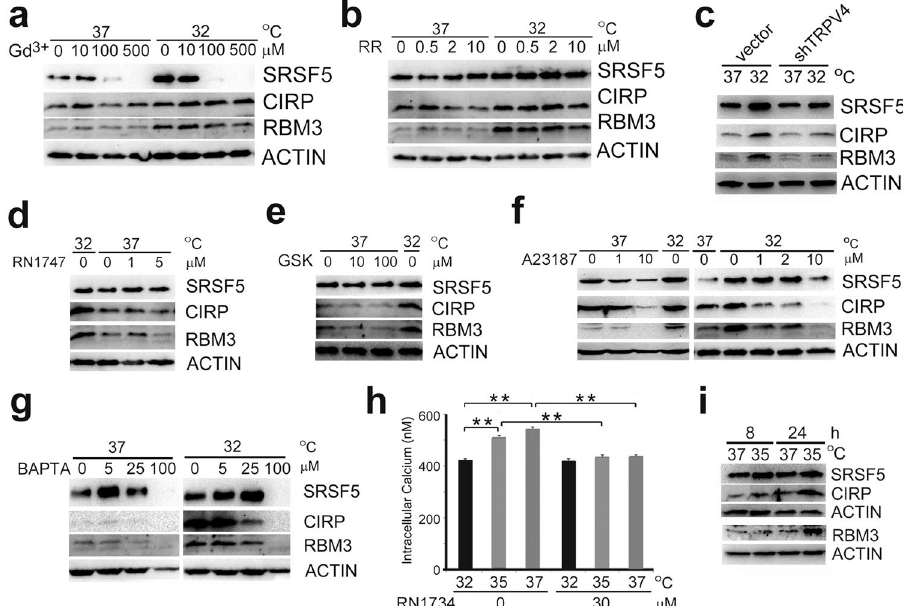
Figure 5. TRPV4 ion channel activity and induction of CIPs. ( a and b ) U-2 OS cells were cultured at 37 °C or 32 °C for 24 h in the presence of indicated doses of gadolinium chloride (Gd 3 + ) ( a ) or ruthenium red (RR) ( b ), and analyzed by western blot (representatives of 3 independent experiments each). ( c ) U-2 OS transfectants transiently expressing vector alone or shRNA against TRPV4 (shTRPV4) were cultured at 37 °C or 32 °C for 16 h, and analyzed by western blot (representative of 5 independent experiments). ( d,e,f and g ) U-2 OS cells were cultured at 37 °C or 32 °C for 24 h in the presence of indicated doses of RN1747 ( d ), GSK1016790A ( e ), A23187 ( f ), or BAPTA-AM ( g ), and analyzed by western blot (representatives of 3 independent experiments each). ( h ) Quantification of intracellular Ca 2 + concentrations by Fura-2 in U-2 OS cells. Cells were cultured at 37 °C, 35 °C or 32 °C for 24 h in the presence or absence of 30 μ M RN1734 (data indicate mean ± SEM; n = 6). Statistical significance was determined by Student’s t -test. ** , P < 0.01. ( i ) U-2 OS cells were cultured at 37 °C or 35 °C for indicated times, and analyzed by western blot (representative of 4 independent experiments). Full- length blots are presented in Supplementary Fig.